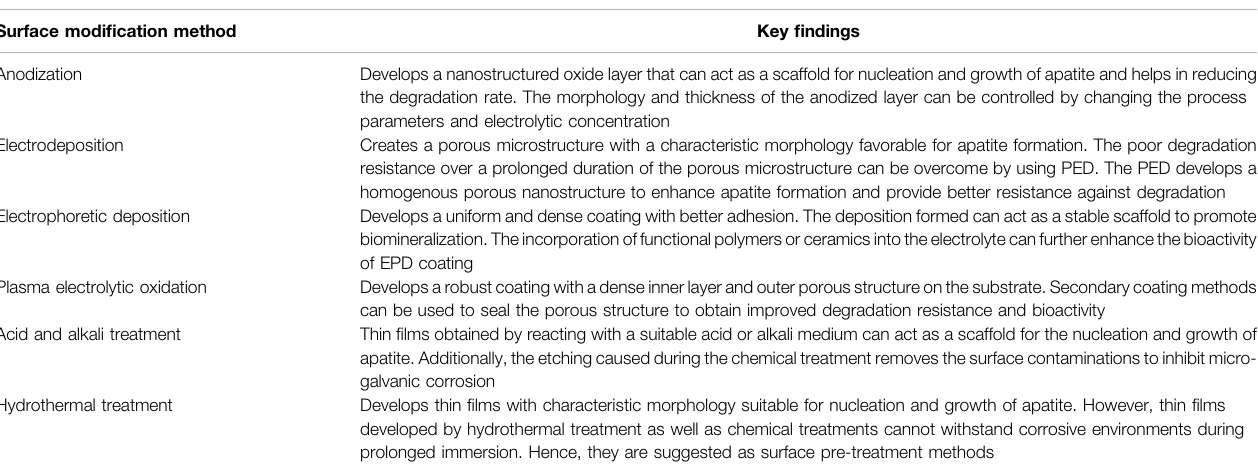
TABLE 1 | Key fi ndings from conversion coating